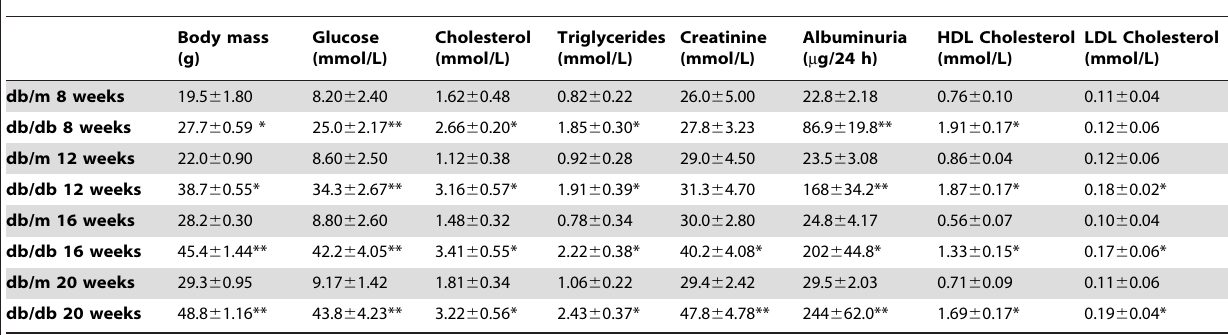
Table 2. Characteristics of db/db mice in renal damage and